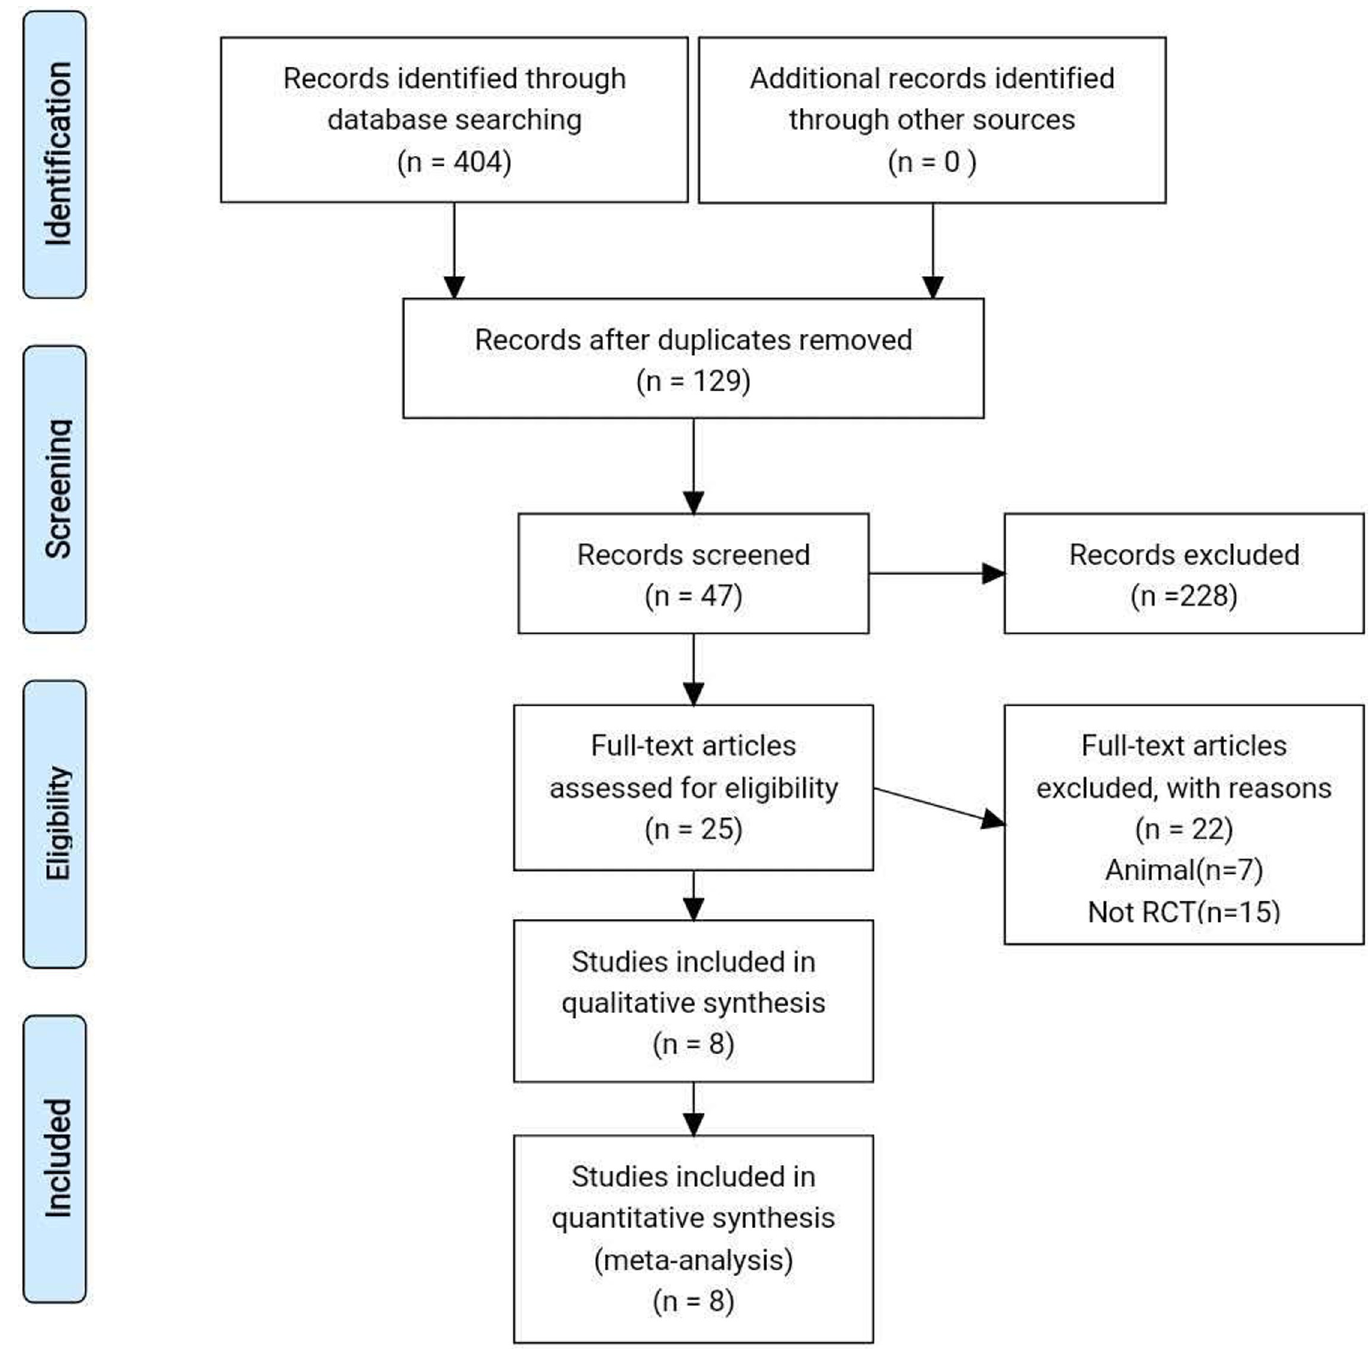
Fig 1. Flowchart of selection of